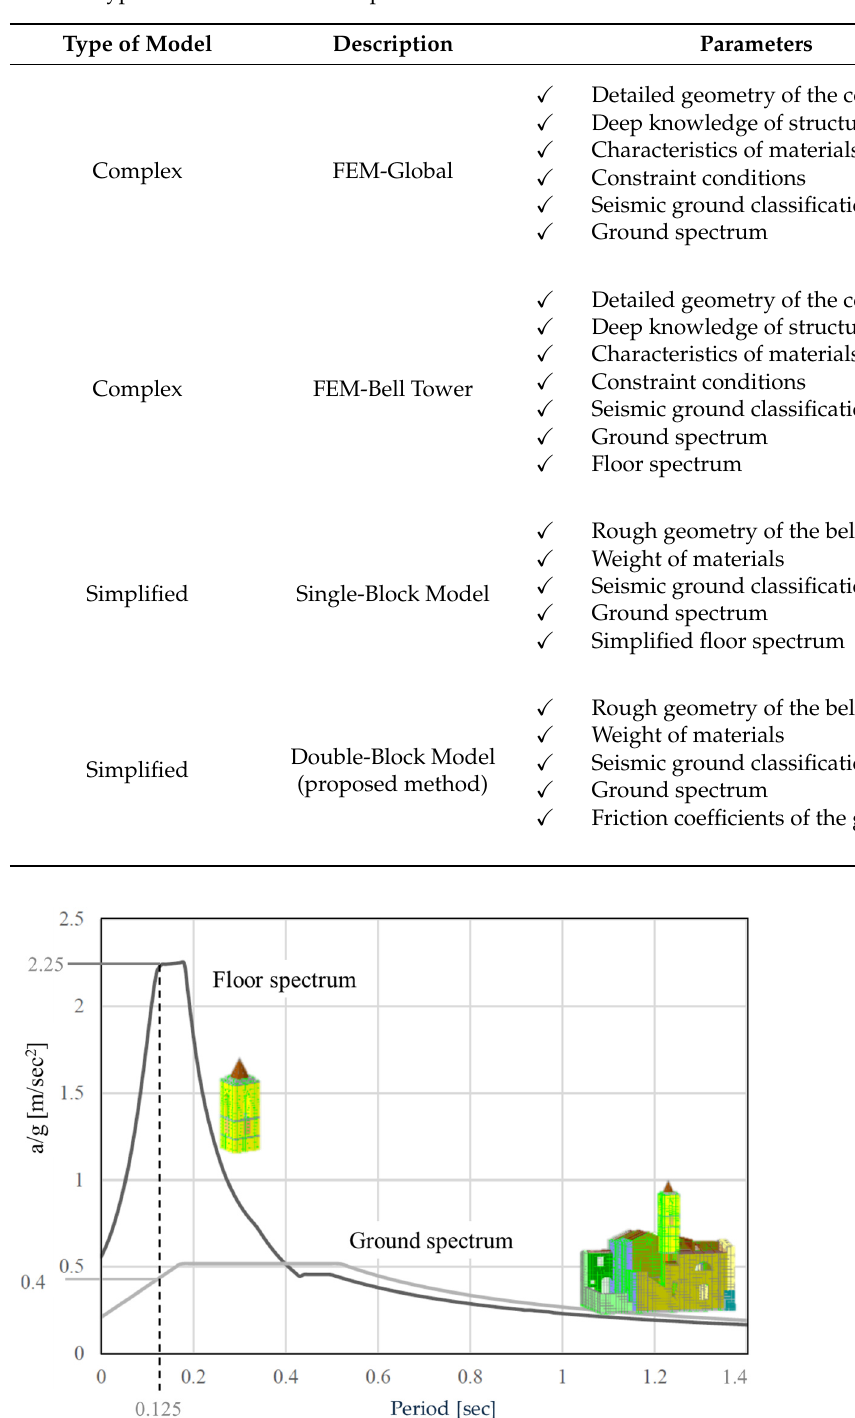
( c ) Figure 9. Possible motions: ( a ) type 1; ( b ) type 2; ( c ) type 3. Figure 9a represents type 1 motion. The inertia forces determine the only rocking motion and the related equations are: (cid:3421)𝑀𝑥(cid:4663) (cid:3034) (𝑡) < 𝑠𝑔𝑛 (cid:4672)𝑥(cid:4662) (cid:3034) (𝑡)(cid:4673) 𝑀𝜇 (cid:3038) 𝑔 𝑥(cid:4663) (cid:3008) (cid:3118) (𝑡)ℎ > 𝑔𝑏 (21) This condition represents the oscillation of the tower and holds until the condition 𝑥(cid:4663) (cid:3008) (cid:3118) (𝑡 (cid:3028) )ℎ = 𝑔𝑏 is reached. Figure 9b represents type 2 motion. The motion of the system is the sliding one, and the related equations are: